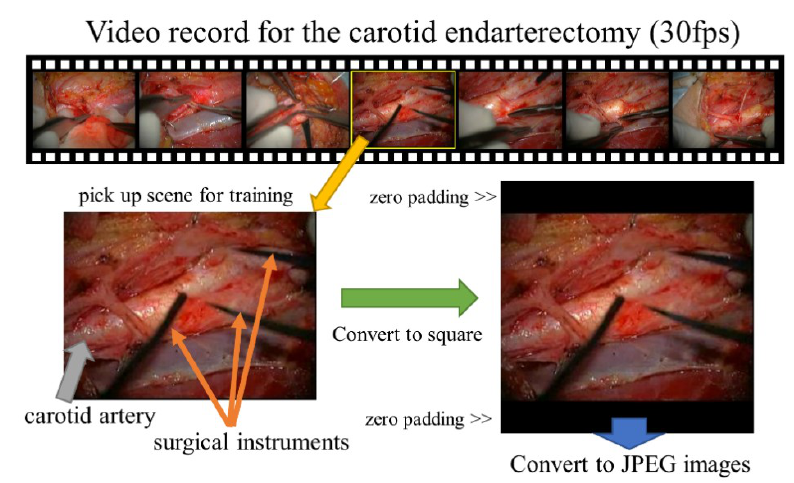
Figure 1. Procedure to select the scene and convert video to JPEG files for the dataset.